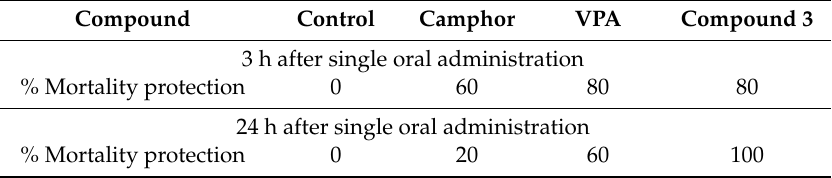
Table 1. Against maximal electroshock (MES)-induced seizures.